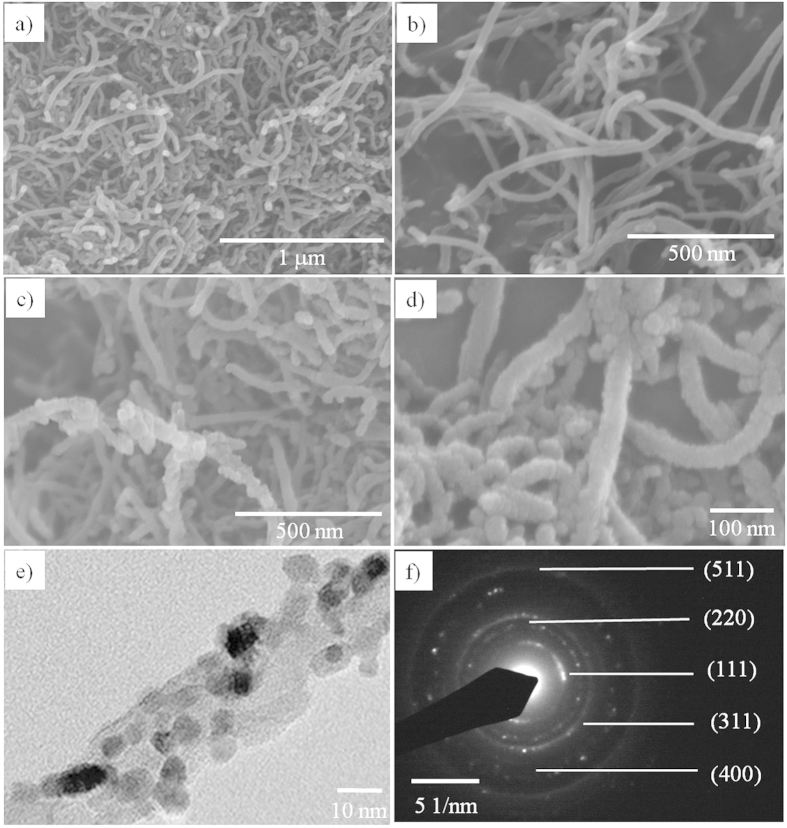
FE-SEM images of pristine MWCNT (a,b), NiCo2O4/MWCNT (c,d). HR-TEM image (e) and SAED pattern (f) of NiCo2O4/MWCNT.